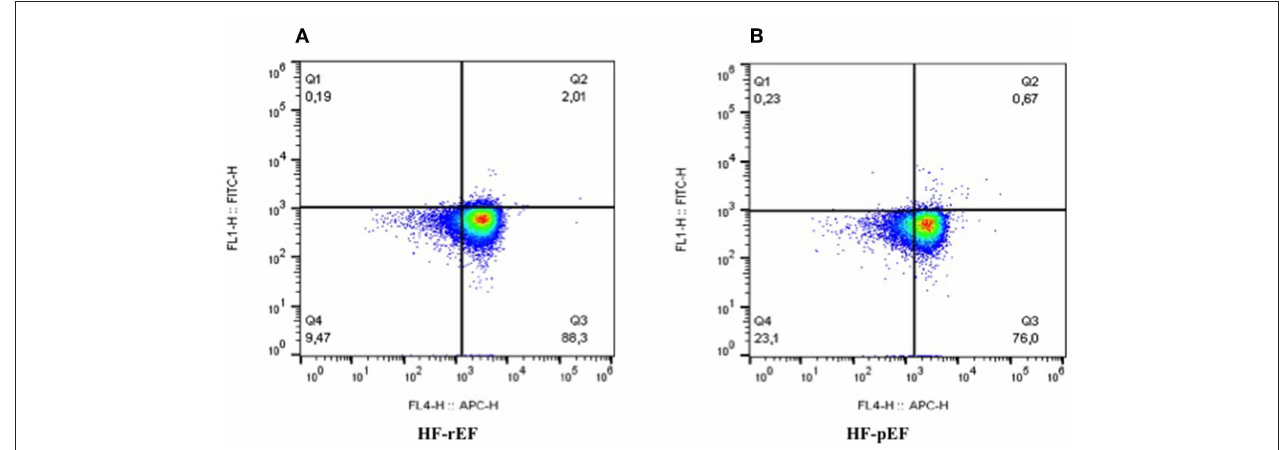
FIGURE 2 | Levels of expression of TLR2 and TLR4 in PBMCs in patients with reduced ejection fraction (A) and preserved ejection fraction (B) . As evident, (A) shows a higher expression of TLRs, in particular of TLR4. FL4-H, TLR4; FL1-H, TLR2; TLRs, toll-like receptors.